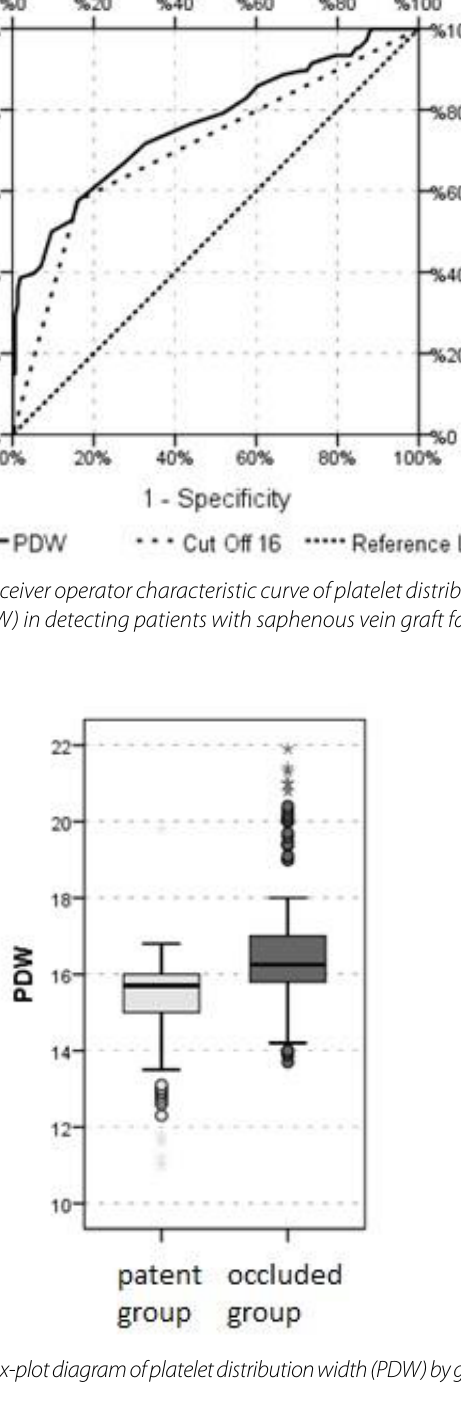
specific marker of platelet activation than other platelet indices, such as mean platelet volume, because PDW does not increase during simple platelet swelling [6] . For these reasons, PDW may provide valuable predictive information regarding the potential for SVG failure following